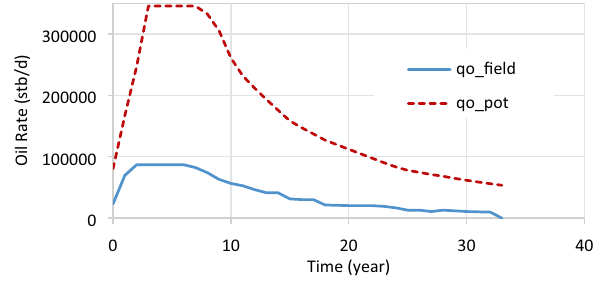
Fig. 4 Optimum oil production profile and oil production potential for strategy TLP with gas lifted wells